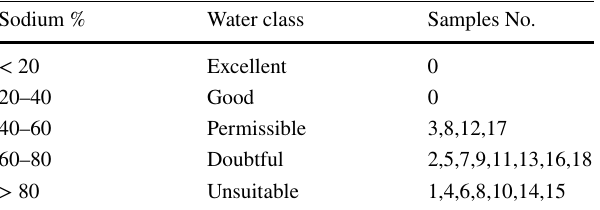
Table 5 Sodium percentage water class (After Sadashivaiah et